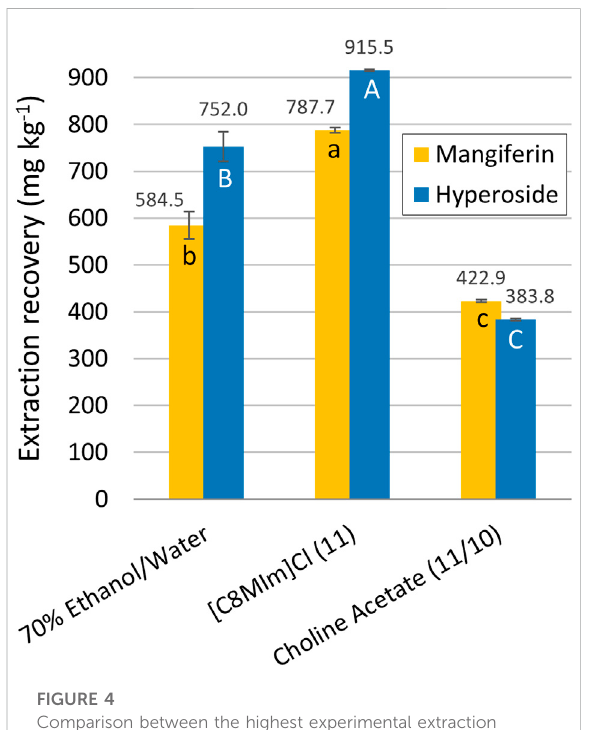
FIGURE 4 Comparison between the highest experimental extraction recoveries obtained with ethanol and ionic liquids aqueous solvents. The letters represent the statistical differences between the averages according to the Tukey test ( p < 0.05) for mangiferin (lowercase) and hyperoside (uppercase).